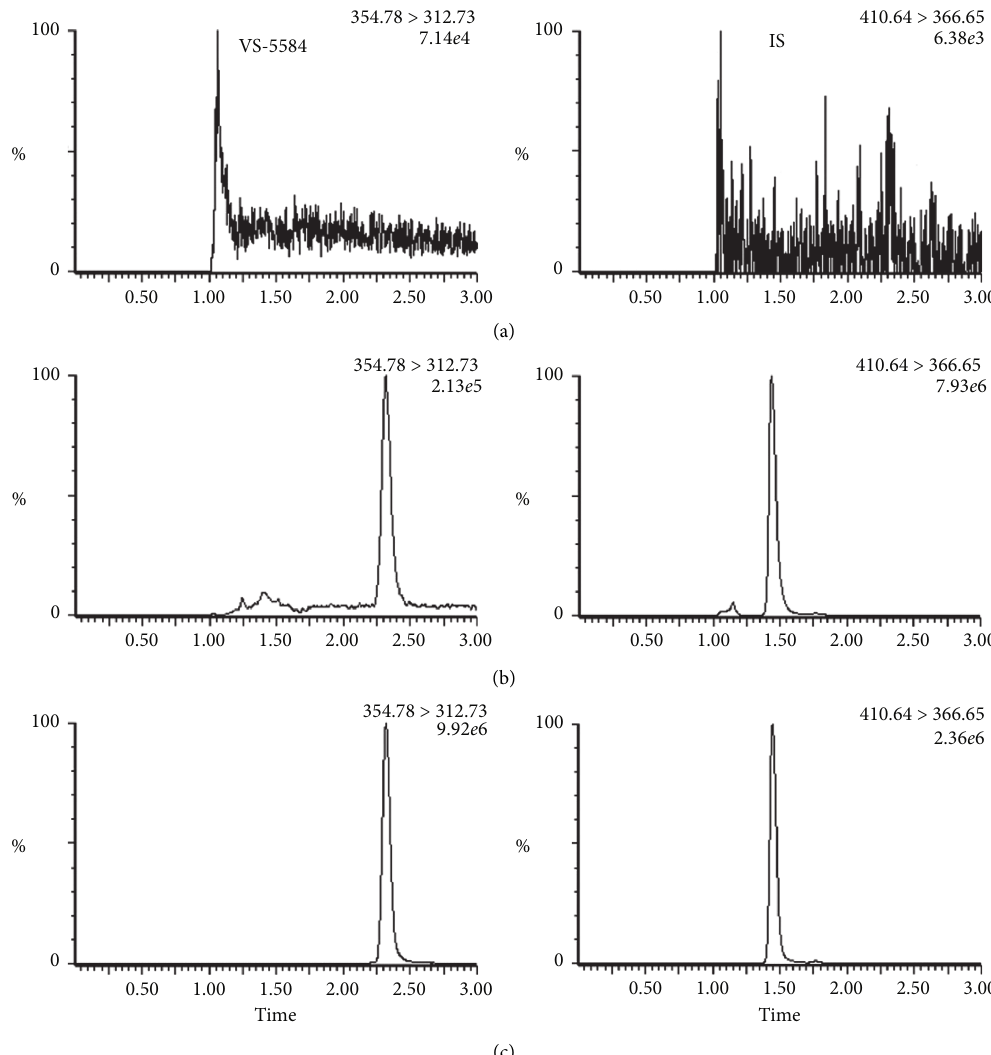
Figure 2: Representative chromatograms: (a) blank plasma sample; (b) blank plasma sample spiked with VS-5584 (LLOQ) and IS; and (c) rat plasma sample collected at 0.5h after